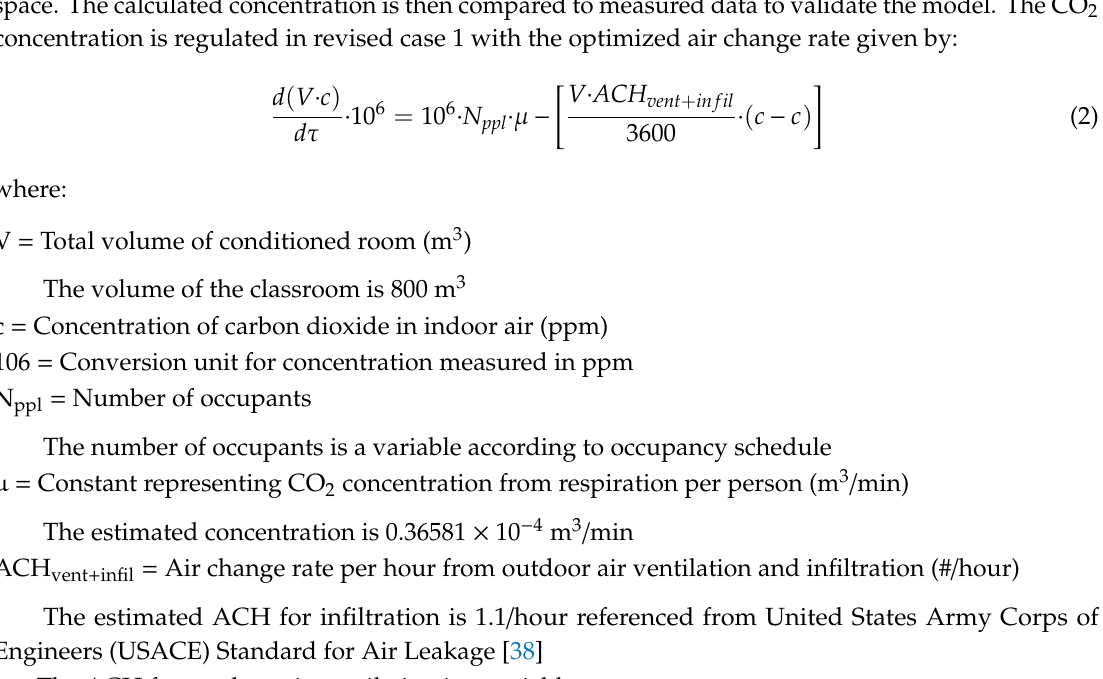
Figure 2. A view of the monitored classroom.